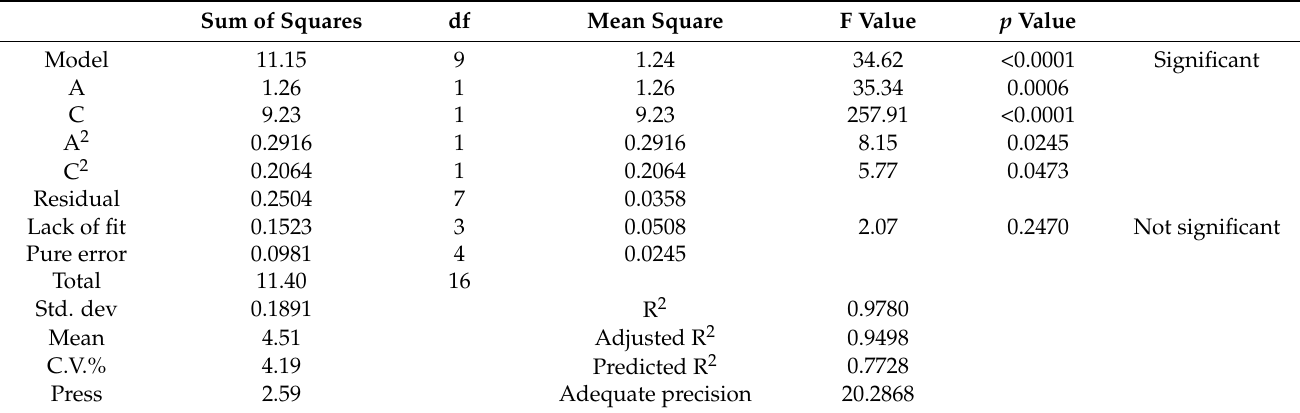
Table 6. Analysis of variance of W/H.